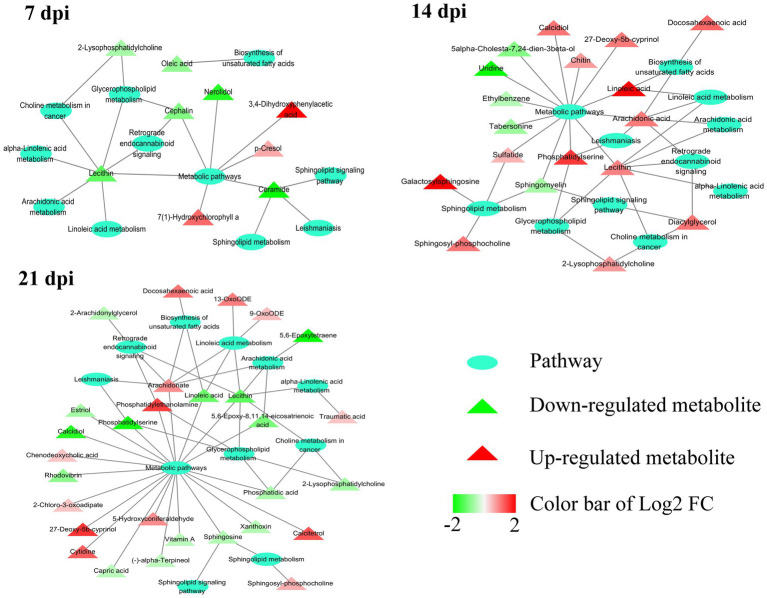
Relationship among 11 common pathways and SAMs. Oval denotes the common pathways among 7, 14, and 21 dpi. Triangle denotes the differentially abundant metabolites. Green and red color represents downregulated metabolites and upregulated metabolites, respectively. In the 11 pathways, 9, 18, and 29 metabolites were significantly altered at 7, 14, and 21 dpi, respectively.